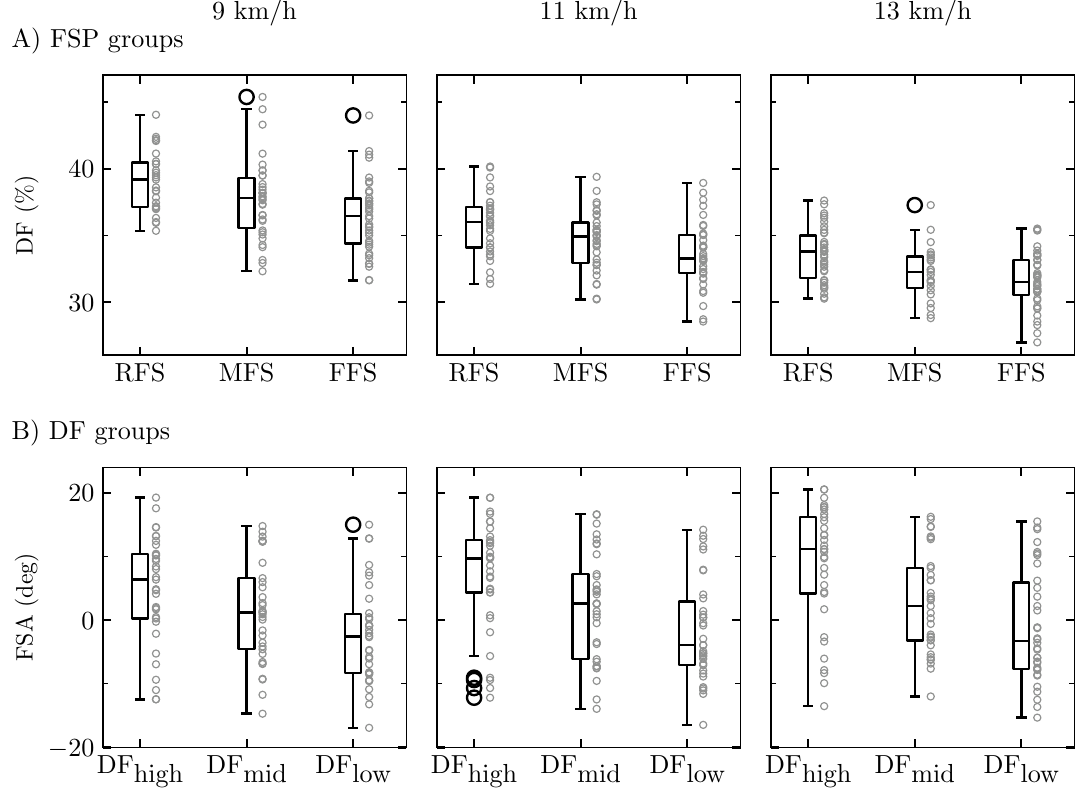
Figure 1. Boxplots of ( A ) the duty factor (DF) for the different foot-strike pattern (FSP) groups, i.e., rearfoot (RFS), midfoot (MFS), and forefoot (FFS) strikers, and ( B ) the foot-strike angle (FSA) for the different DF groups, i.e., high (DF high ), mid (DF mid ), and low (DF low ) DF runners, at 9, 11, and 13 km/h. The box extends from the lower to upper quartile values of the data, with a line at the median. The whiskers extend from the box to show the range of the data while flier points (black empty circles) are those past the end of the whiskers. The upper whisker extends to the last data less than Q3 + 1.5 (Q3 – Q1), where Q1 and Q3 are the first and third quartile. Similarly, the lower whisker extends to the first data greater than Q1 – 1.5 (Q3 – Q1). The small gray empty circles denote the data of each